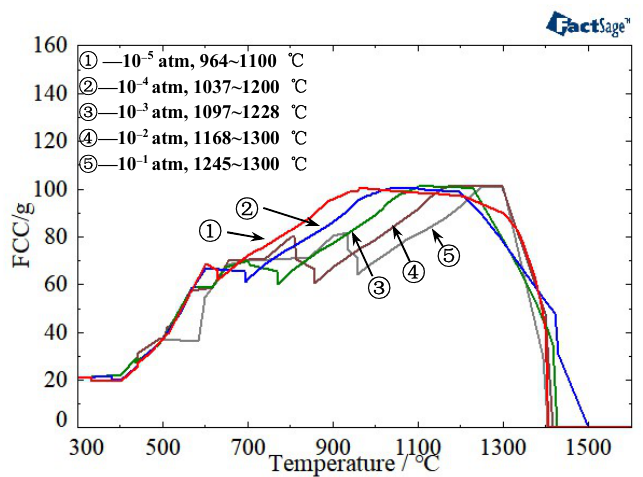
Figure 7. Temperature range of FCC existing under 10 −5 ~10 −1 atm.